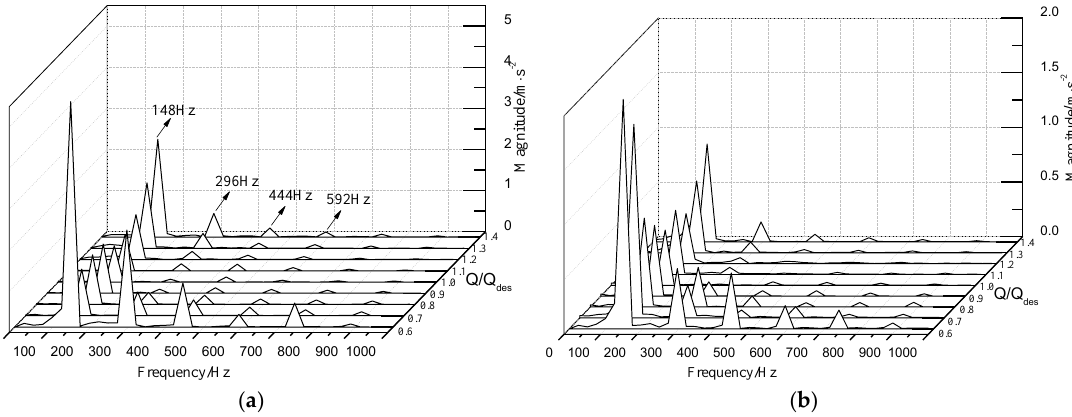
Figure 23. Frequency distribution of the acceleration under different flow conditions: ( a ) X direction; ( b ) Y direction.